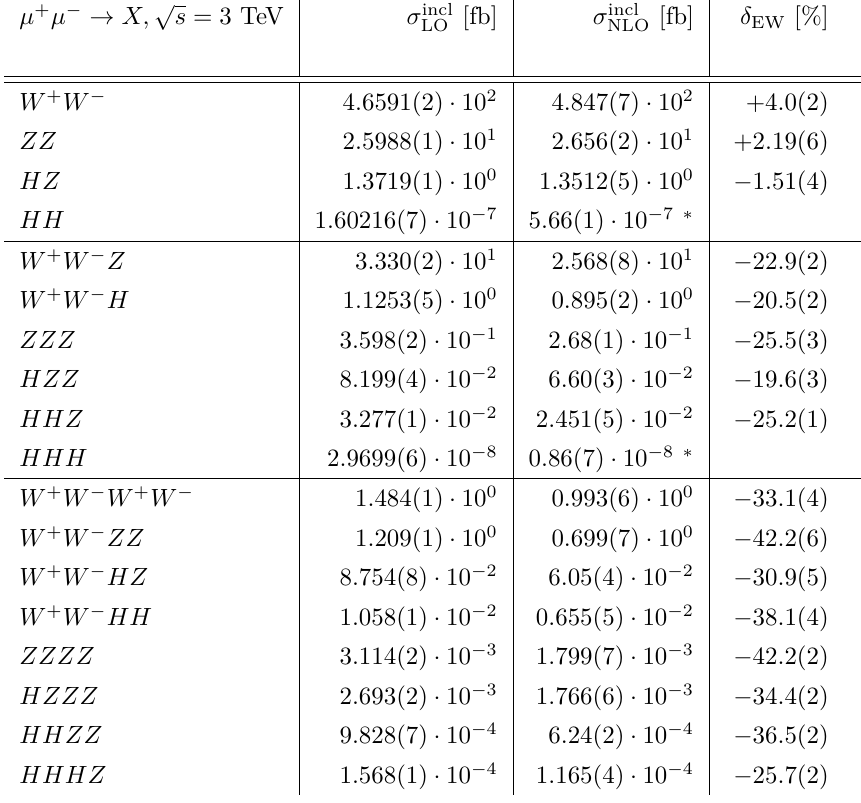
Table 1 . Total inclusive cross sections at LO and NLO EW with corresponding relative corrections δ EW , for two-, three- and four-boson production at contributions, we refer to the discussion in the text.